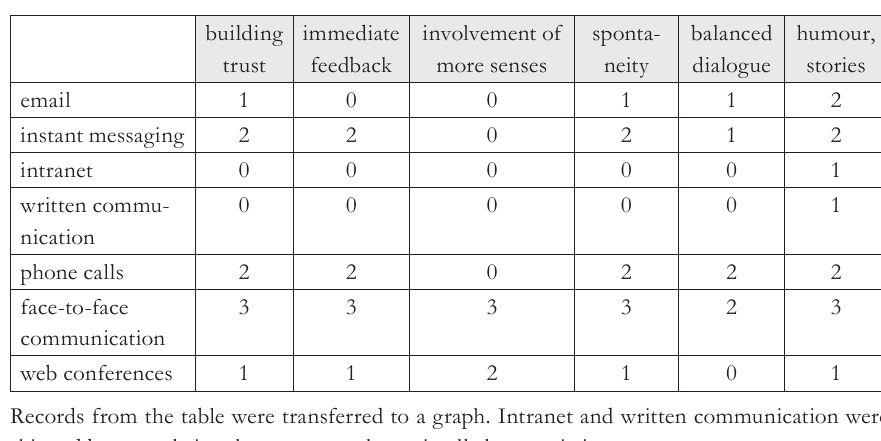
Tab. 2 - Assessment of Communication Tools in Key Requirements. Source: own research